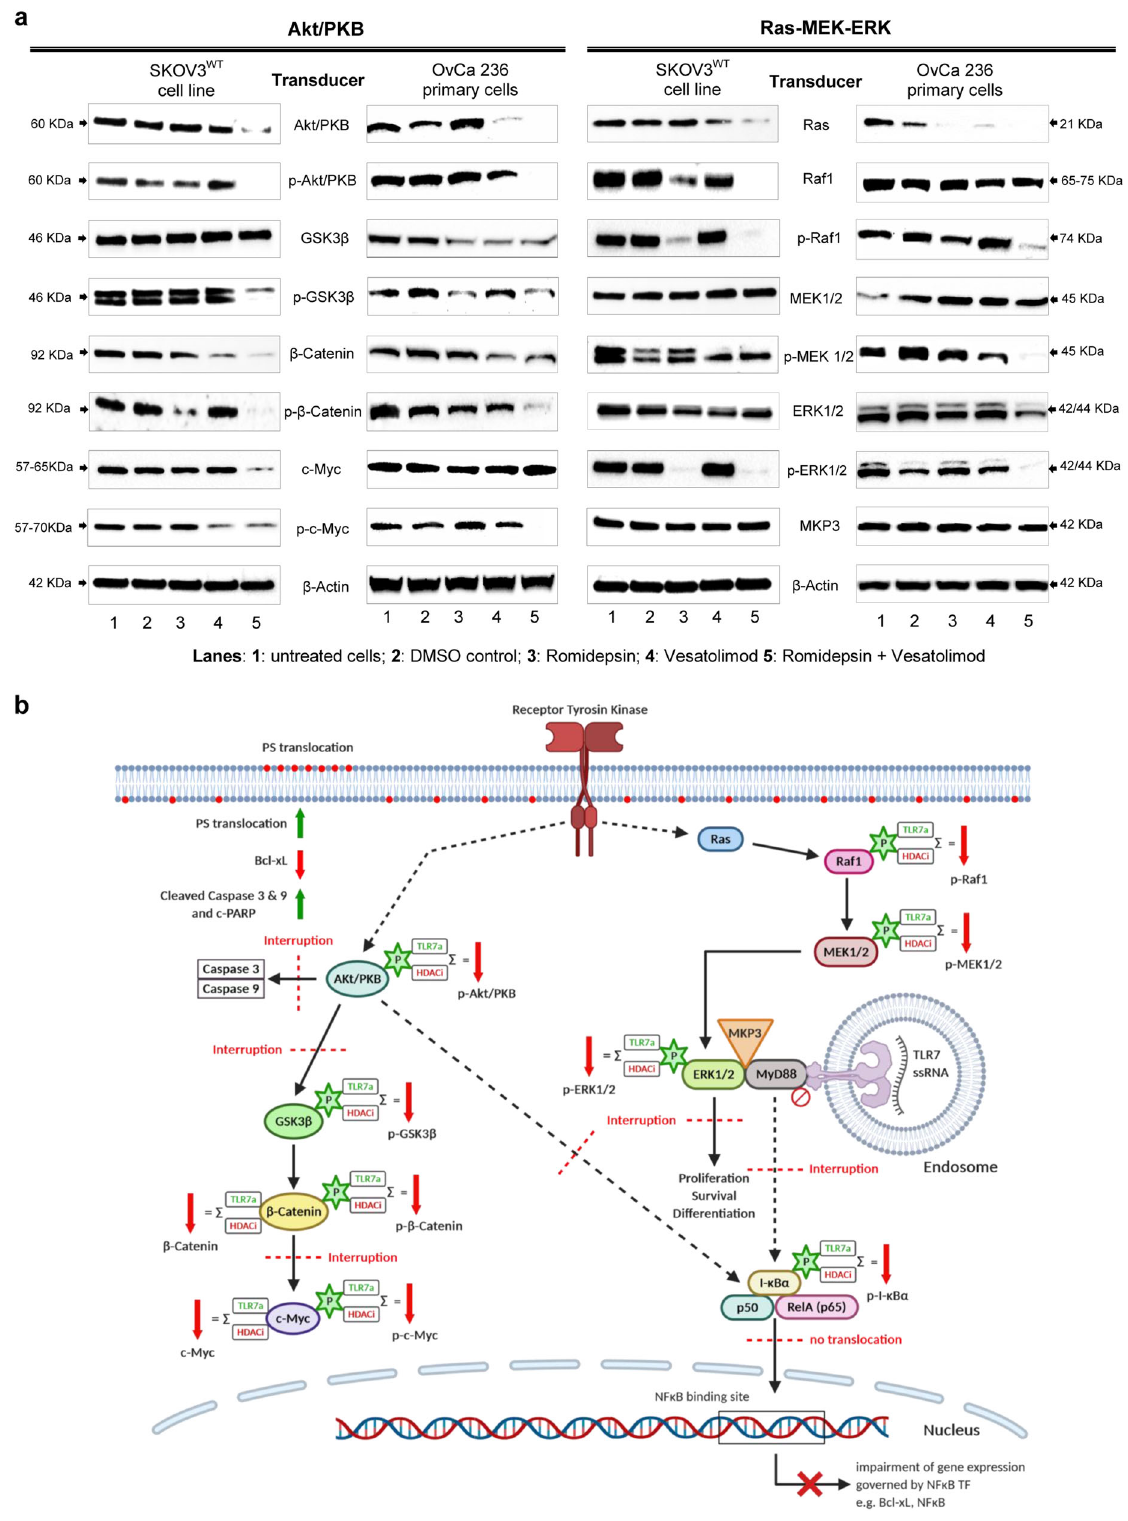
Fig. 7 Akt/PKB and Ras-MEK-ERK signal transduction pathways are disrupted by HTCT. a IKB α (see Fig. 6) is phosphorylated via Akt/PKB transducers, which were largely disrupted by HTCT in SKOV3 WT and OvCa236 carcinoma cells. Note the selective hypophosphorylation steady state of the MEK-ERK transducers. Protein synthesis of transducers of both cascades is affected by the exposure to single drugs and their combinations, in particular for some elements of the Akt/PKB pathway. The phosphate exchange between these transducers is globally disrupted. b Sketch depicting global disruption points of the TLR7-NF κ B, Akt/PKB and Ras-MEK-ERK cascades for HDACis, TLR7/8as and their combinations in OC cells (Illustration created with BioRender.com). Western blot results are representative of several experiments carried out in cell lines and primary ovarian carcinoma cells isolated from ascites.